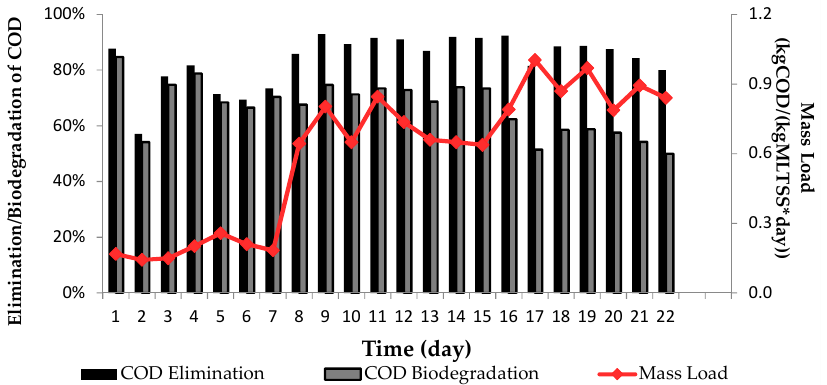
Figure 7. The efficiency of biodegradation and elimination as a function of mass loading in the Figure 7. The e ffi ciency of biodegradation and elimination as a function of mass loading in the experimental plant. experimental